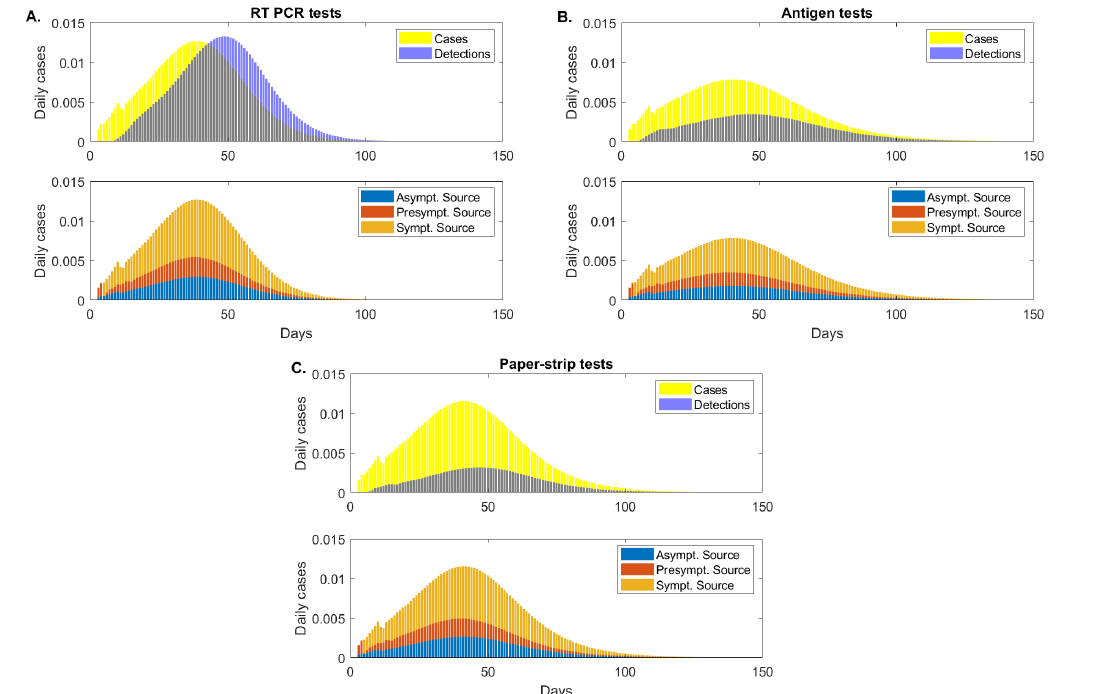
Figure 4. Asymptomatic, presymptomatic and symptomatic transmissions (as proportion of the total population) . ( Upper figures ): daily cases (yellow bars) and daily detections (blue bars); ( Lower figures ): daily cases due to asymptomatic transmission (blue bars), presymptomatic transmission (red bars) and symptomatic transmission (orange bars), as given by ( V ) = 2, test return delay 5 days; model Equation (5) for fixed testing capacity. Panel ( A ): RT-PCR, detection threshold log 10 ( V ) = 5, test return delay 0.5 days; Panel ( C ): paper-strip test, detection Panel ( B ): antigen test, detection threshold log 10 ( V ) = 6, test return delay 0.1 threshold log 10